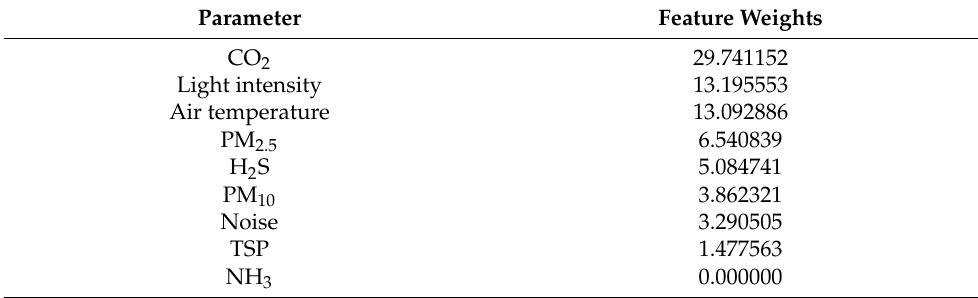
Table 2. Parameter feature importance ranking based on the LightGBM